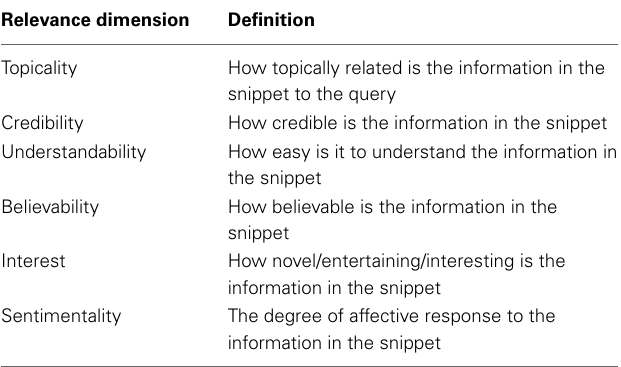
Table 2 | Definition of relevance